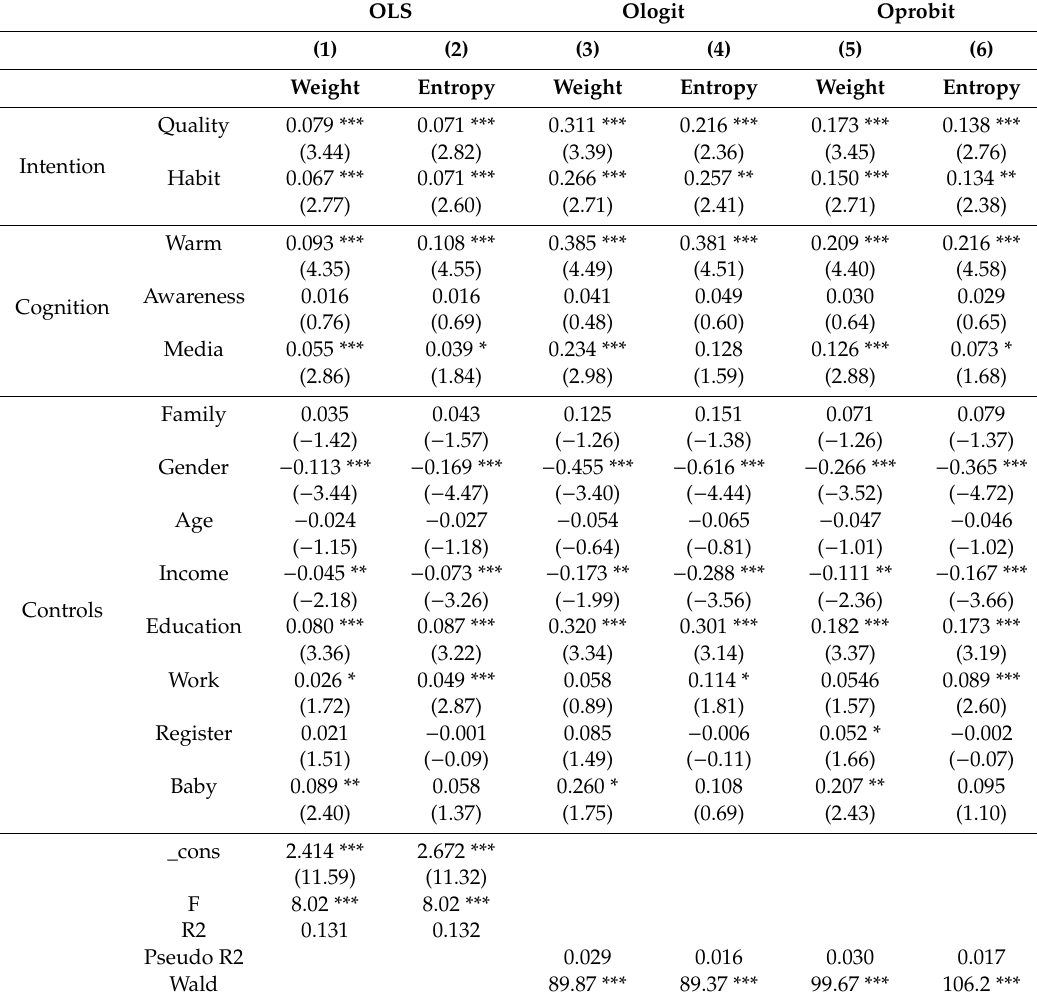
Table 4. Logistic regression analysis on residents’ low-carbon